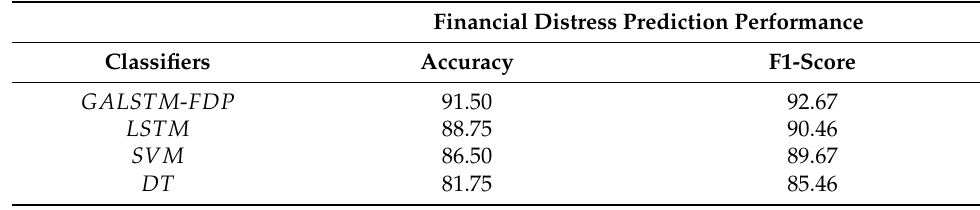
Table 4. Comparison of GALSTM-FDP, LSTM, SVM, and DT in solving the FDP